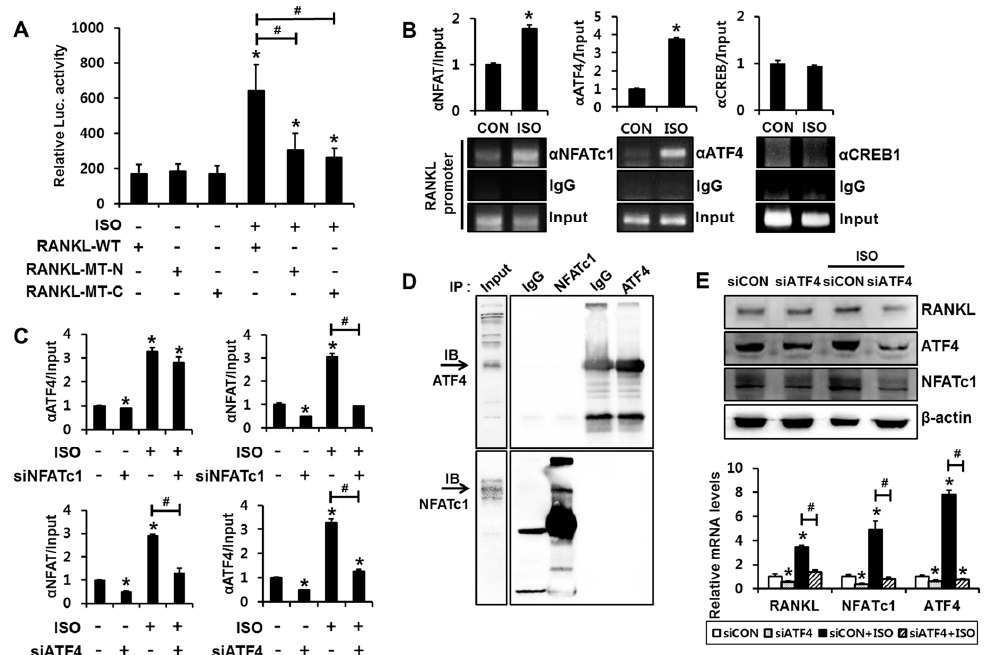
Figure 3. Binding of both NFATc1 and ATF4 to the RANKL promoter is necessary for transactivation of RANKL gene. ( A ) ISO increased RANKL promoter-reporter activity in a NFAT-binding element- and CRE-like element-dependent manner. C2C12 cells were transfected with the indicated RANKL promoter reporters and incubated for 24 h in the presence or absence of ISO, followed by the luciferase assay. Data were presented as the firefly luciferase activity relative to Renilla activity. * p < 0.05, compared to RANKL-WT without ISO. RANKL-WT: luciferase reporter containing approximately 2 kb of mouse RANKL promoter; RANKL-MT-N: a reporter with mutated sequences in NFAT binding element ( − 941 to − 936 bp); RANKL-MT-C: a reporter with insertion of mutations in CRE-like element ( − 1093 to − 1086 bp). ( B ) ISO increased the binding activity of NFATc1 and ATF4, but not CREB1, to the mouse RANKL promoter. C2C12 cells were incubated for 24 h with ISO and the chromatin immunoprecipitation assay was performed with antibodies to NFATc1, ATF4, CREB1, and control IgG. The RANKL promoter region containing the NFAT binding element or CRE-like element was then amplified. The quantitative chromatin immunoprecipitation data were normalized to the input and were presented as the relative values to CON. * p < 0.05, compared to CON. ( C ) The knockdown of NFATc1 blocked ISO-induced NFATc1 binding, but did not affect ISO-induced binding of ATF4 to the RANKL promoter (upper panels). The knockdown of ATF4 blocked not only ISO-induced ATF4 binding but also NFATc1 binding, to the RANKL promoter (lower panels). C2C12 cells were transfected with the indicated siRNAs and incubated for 24 h in the presence or absence of ISO, followed by chromatin immunoprecipitation assays. * p < 0.05, compared to vehicle-treated siCON. # p < 0.05, compared to ISO-treated siCON. ( D ) NFATc1 was not co-immunoprecipitated with ATF4. NFATc1 and ATF4 were overexpressed in C2C12 cells, and immunoprecipitation (IP) was performed with the indicated antibodies, followed by immunoblotting (IB). Arrows indicate the bands for ATF4 (upper panel) and NFATc1 (lower panel). ( E ) The knockdown of ATF4 blocked ISO-induced RANKL and NFATc1 expression. C2C12 cells were transiently transfected with ATF4 siRNA (siATF4) or non-targeting siRNA (siCON) and incubated for 24 h in the presence or absence of ISO, followed by RT-PCR and Western blot analyses. * p < 0.05, compared to siCON. # p < 0.05, compared to the indicated pair. Statistical significance was determined using one-way ANOVA.